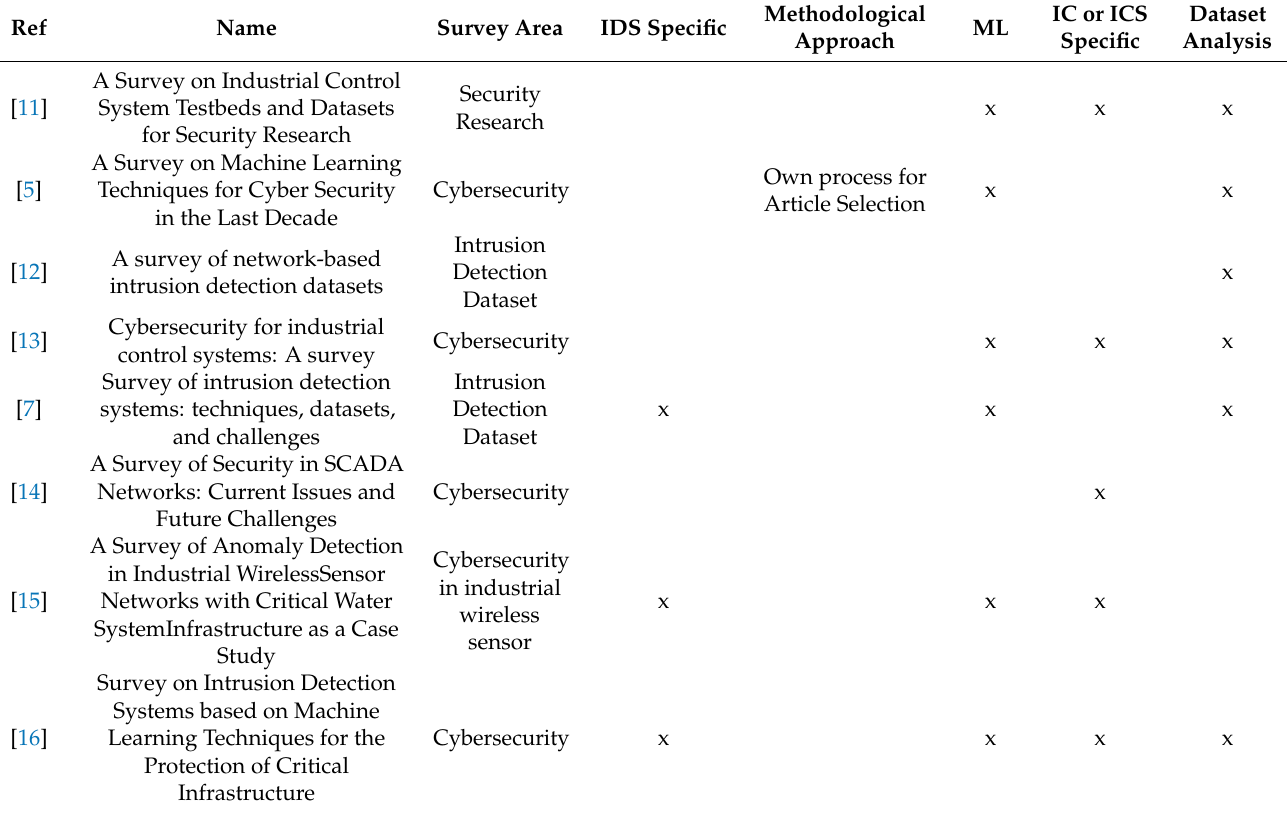
Table 1. Comparison of this survey and similar